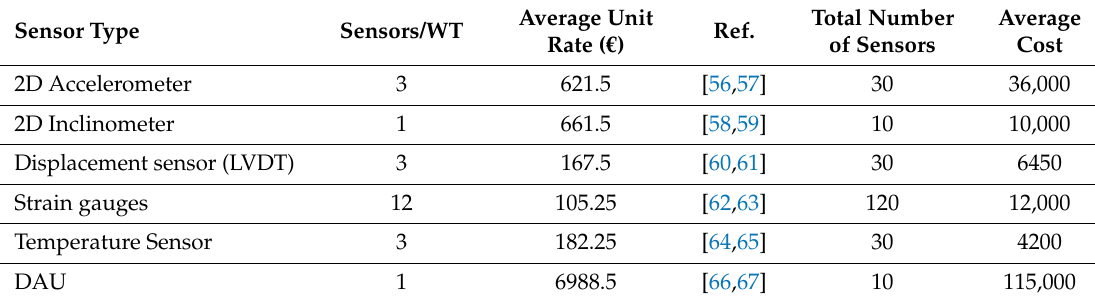
Table 8. Hardware costs in Baseline scenario.